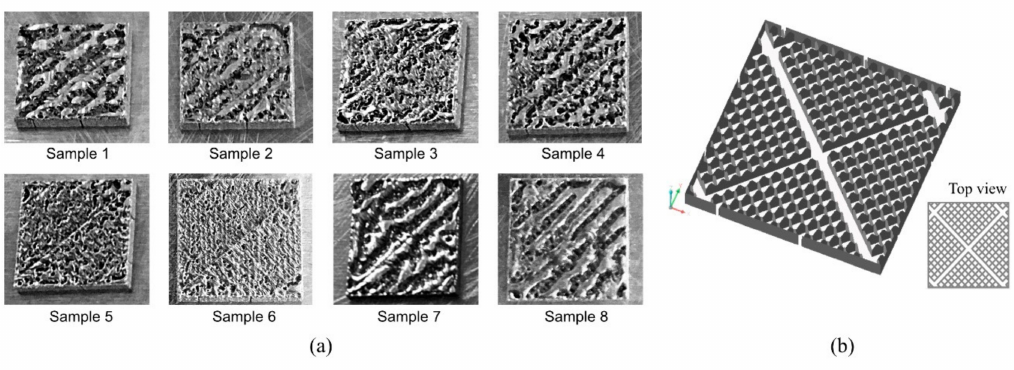
Figure 7. ( a ) Interface between support structures, the lower face of the part (down-skin), and the internal area of the part (in-skin); ( b ) support structure of block